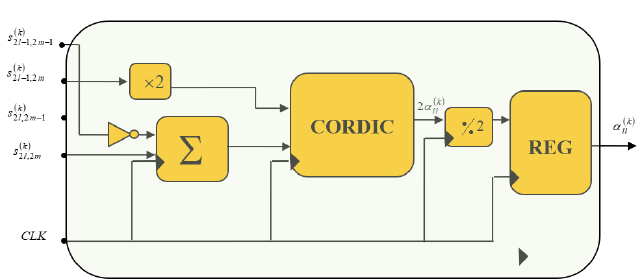
Figure 11. Material